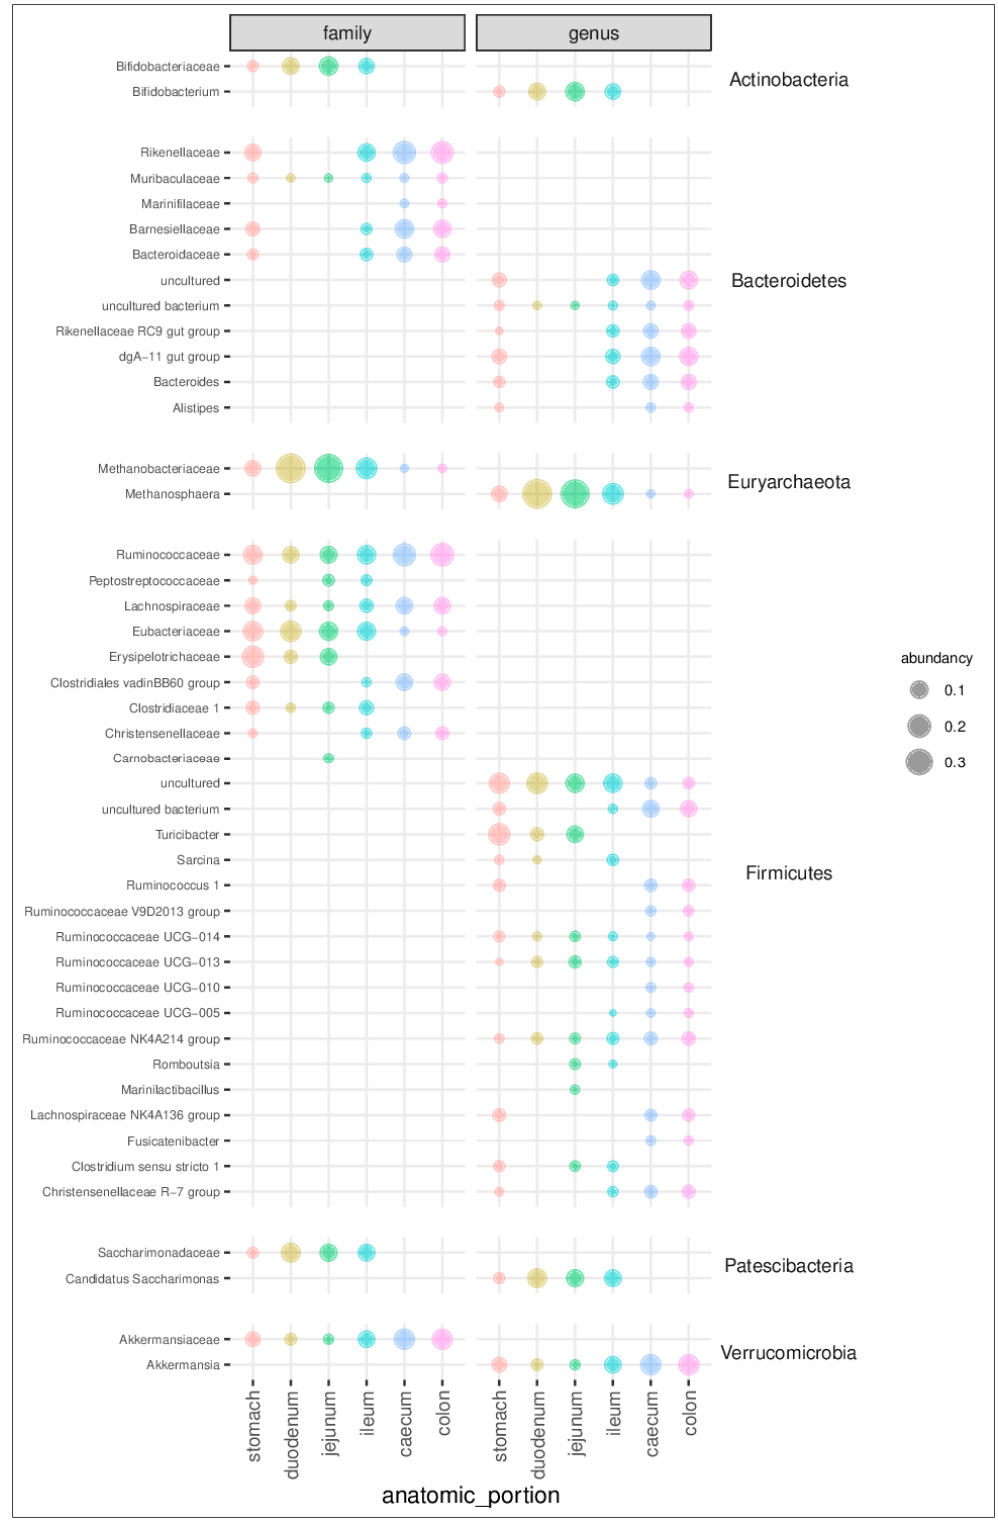
Figure 2. Bubble chart of relative abundances for the families and genera that were identified in the rabbit gut microbiota from 84 samples taken along the gastrointestinal tract (stomach, duodenum, jejunum, ileum, caecum, and colon). The names of the families and genera are reported on the left side of the figure. The name of phyla to which the different families and genera belong are reported on the right side of the figure. The central columns report the graphical representation of the abundance of the family and genus, respectively. Only taxa with relative abundance ≥ 1% are